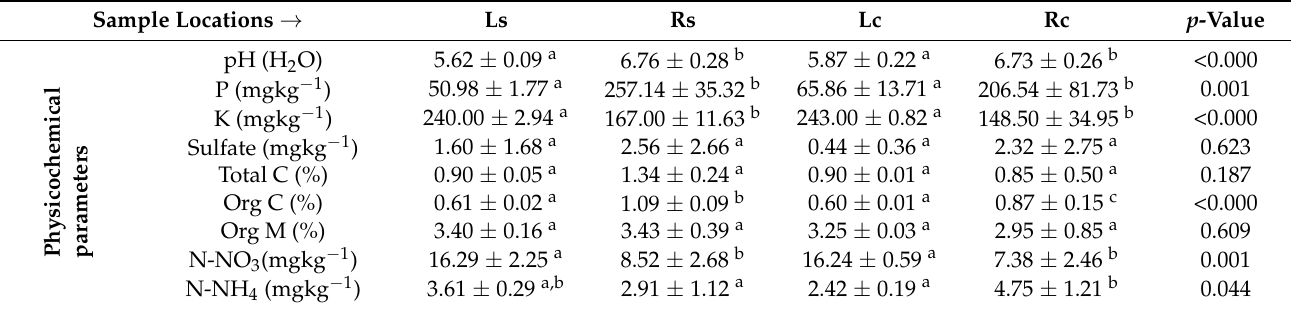
Table 1. Mean values of chemical properties of maize rhizosphere and surrounding soils. Sample Locations